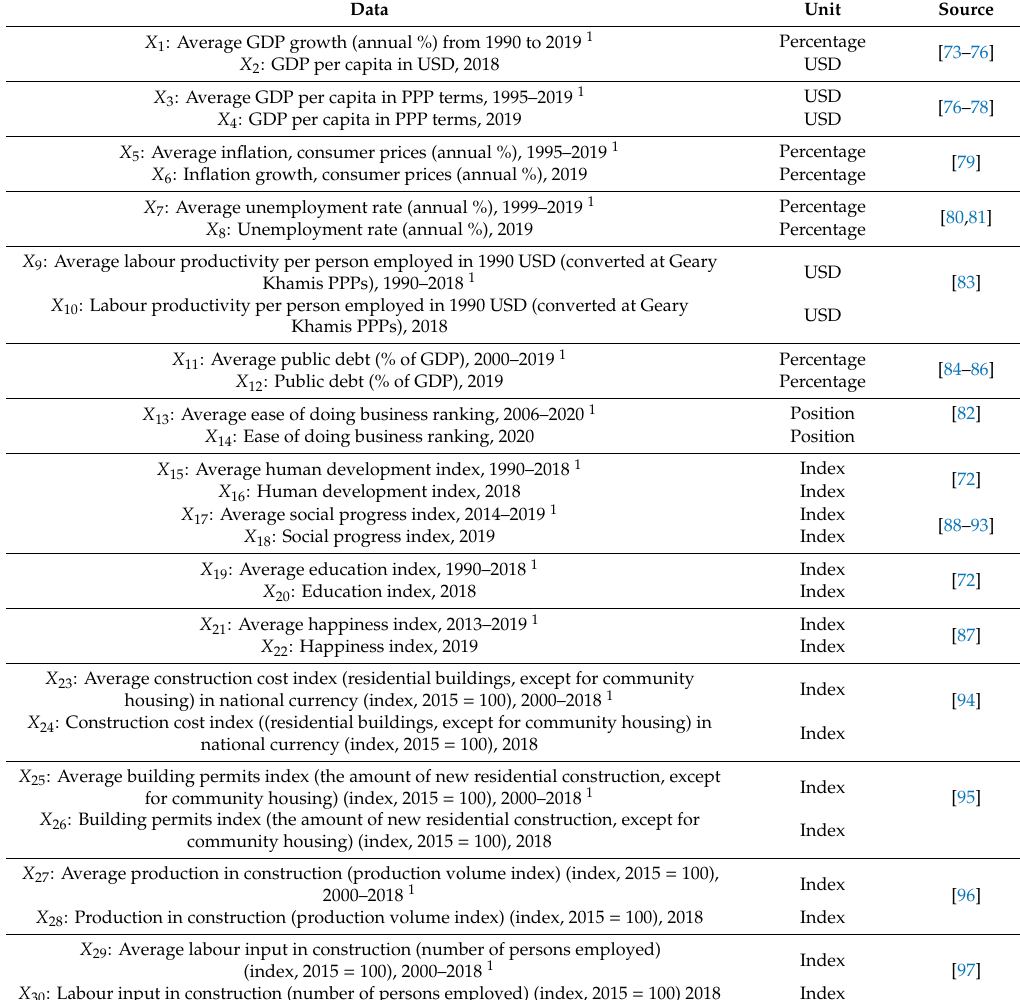
Table 1. Data from di ff erent